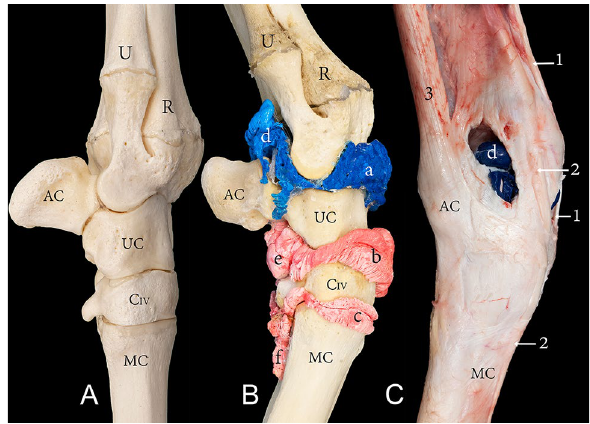
Figure 5. Lateral view of the right carpus showing ( A ) bones, ( B ) casting, and ( C ) dissection. R, the distal end of the radius; U, the distal end of the ulna; AC, accessory carpal bone; UC, ulna carpal bone; CIV, carpal bone IV; MC, metacarpal bone; a, radiocarpal joint cavity; b, intercarpal joint cavity; c, carpometacarpal joint cavity; d, lateropalmar pouch of the radiocarpal joint; e, palmar pouch of the intercarpal joint; f, lateral pouch of the carpometacarpal joint; 1, extensor carpi radialis tendon; 2, lateral digital extensor tendon; 3, extensor carpi